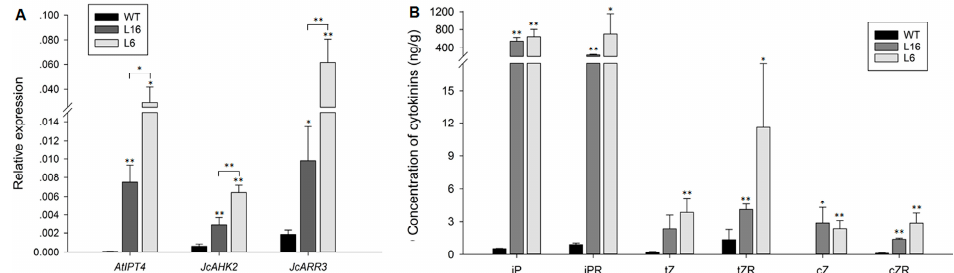
Figure 2. The cytokinin contents were increased in JcTM6:AtIPT4 transgenic J. curcas . ( A ) Relative expression of AtIPT4 , JcAHK2, and JcARR3 in the inflorescence buds of the wild-type (WT) and transgenic J. curcas plants. The levels were normalized using the amplified products of JcAct1 . The values are presented as the means ± standard deviations ( n = 3). ( B ) Six cytokinin species in the inflorescence buds of transgenic and WT plants were examined. iP, isopentenyladenine; iPR, isopentenyladenosine; tZ, trans-zeatin; tZR, trans-zeatin riboside; cZ, cis-zeatin; and cZR, cis-zeatin riboside. The values represent the means ± standard deviations ( n = 3). Student’s t -test was used for the statistical analyses: * p ≤ 0.05, ** p ≤ 0.01.